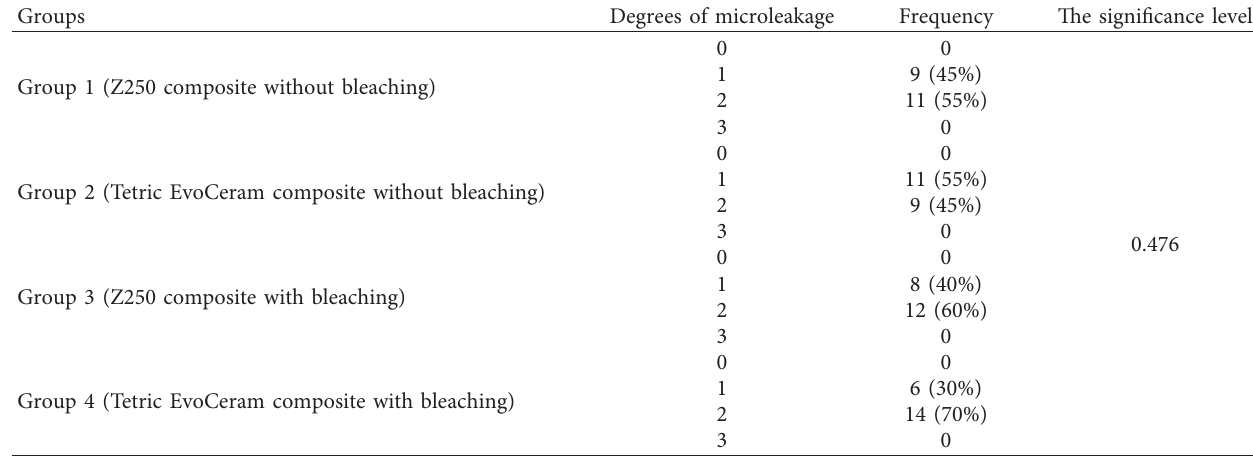
Table 1: Frequency and percentage of each degree of microleakage in the studied